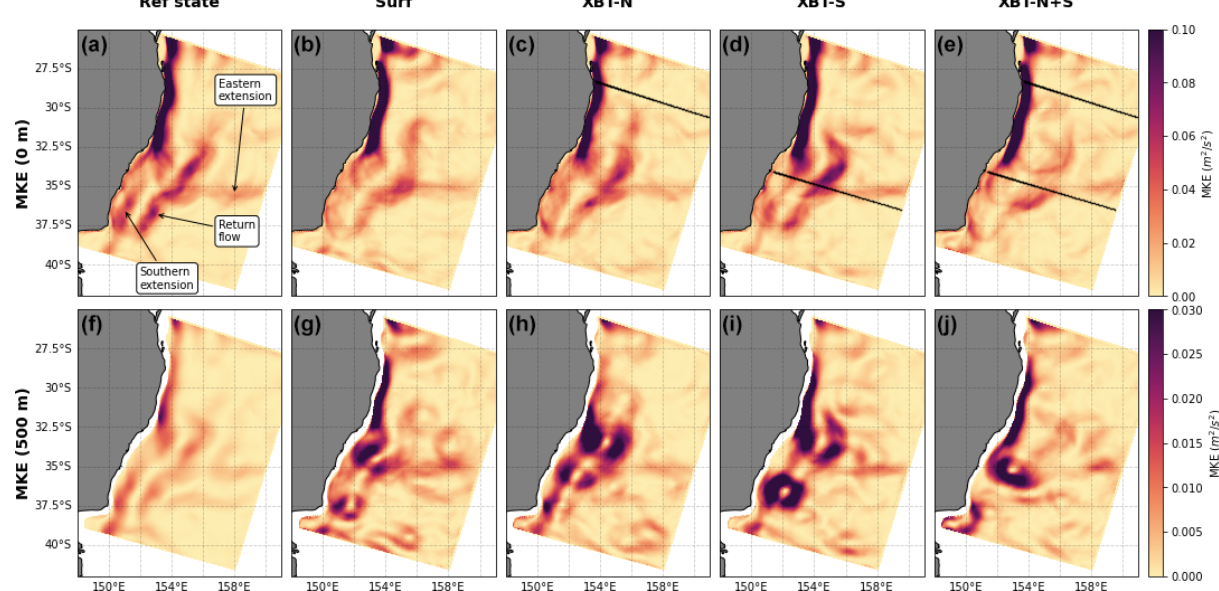
Figure 4. The surface MKE for the (a) reference state, and OSSEs (b) surf, (c) XBT-N, (d) XBT-S, (E) XBT-N+S, and the MKE at 500m for the (f) reference state, and OSSEs (b) surf, (c) XBT-N, (d) XBT-S, and (e) XBT-N+S. Black lines in panels (b) – (d) indicate location of the XBT lines. Key circulation features that emerge in the long-term mean are shown, including the EAC eastern and southern extensions and the return flow, which flow eastwards, southwards, and northwards,